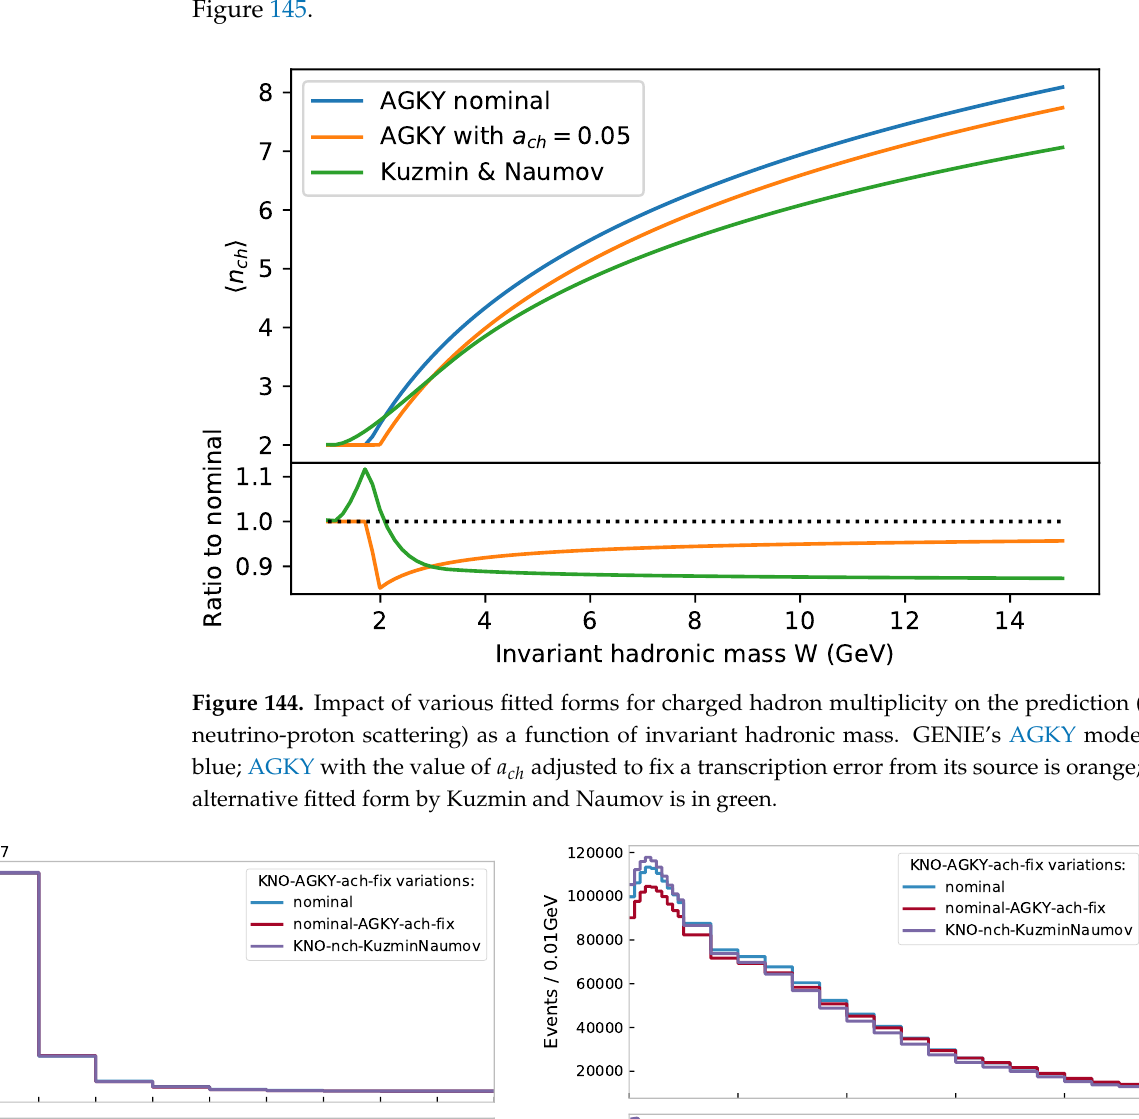
n ch described in the (cid:104) (cid:105)